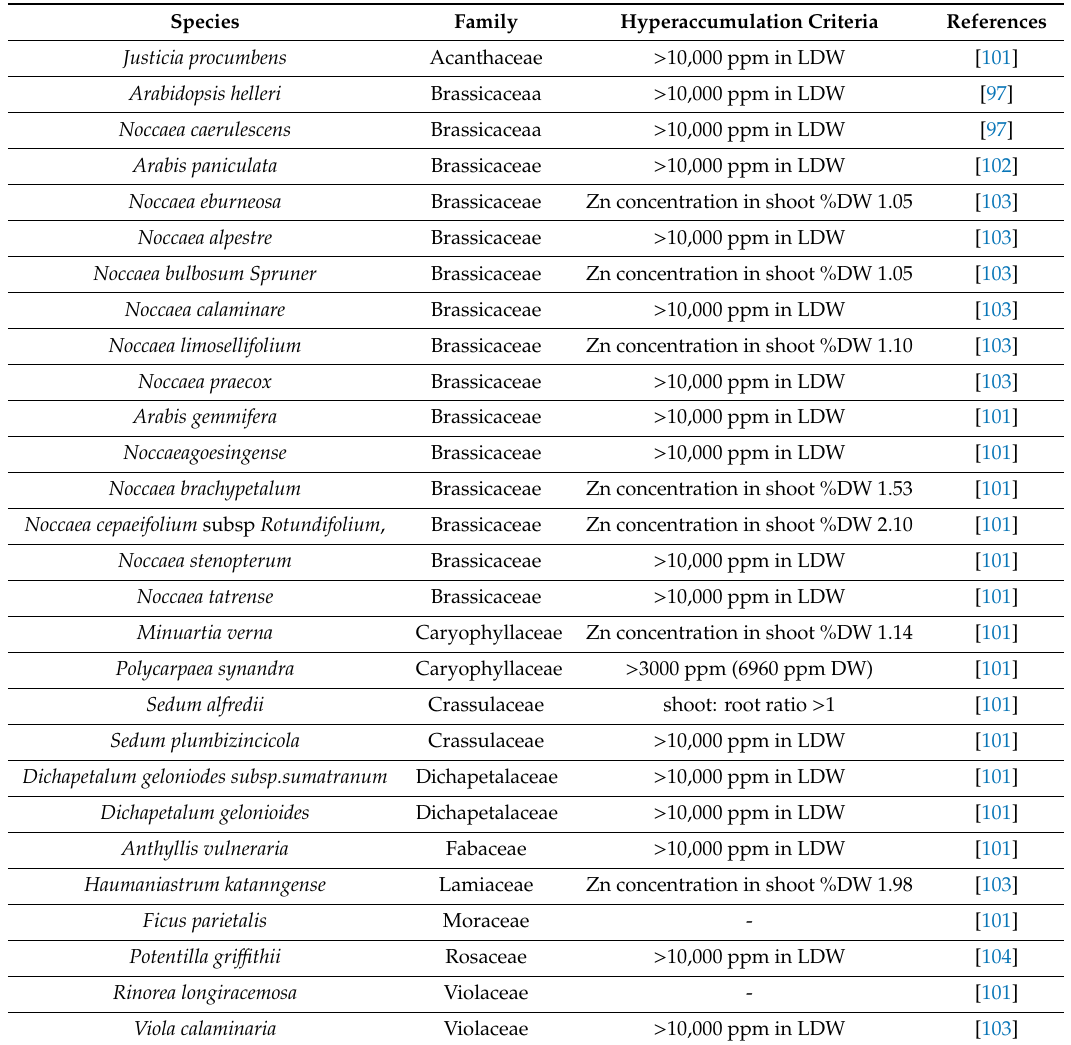
Table 1. List of Zn hyperaccumulator